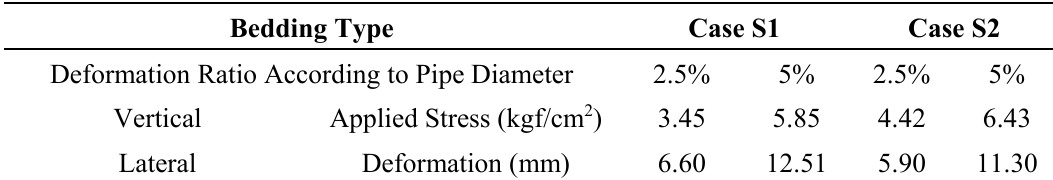
Table 3. The measured vertical and lateral deformations of PE pipe.